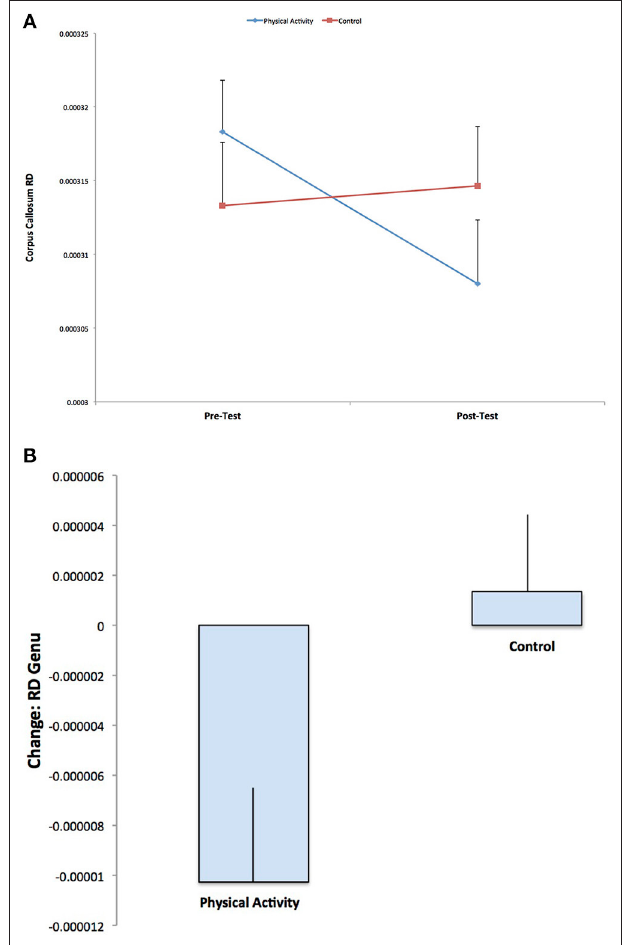
FIGURE 3 | Illustration of the significant Group × Time interaction for RD in the genu of the corpus callosum, with the physical activity group showing significant decreases in RD from pre-test to post-test, with no changes in RD for the control group ( p = 0.592). The result suggests increased estimates of white matter myelination with physical activity